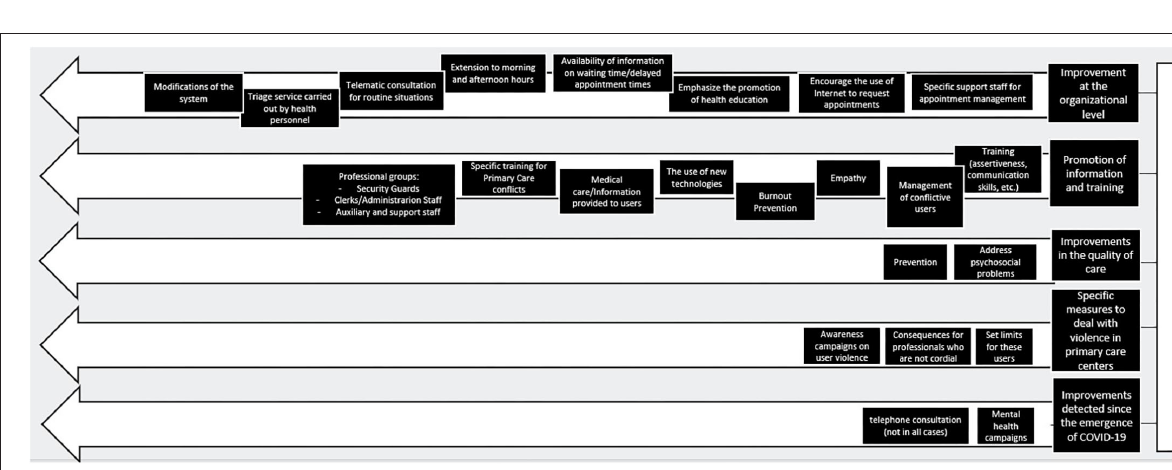
FIGURE 2 | Possible solutions to the conflicts in Primary Care centers from the users’ perspective: topics and